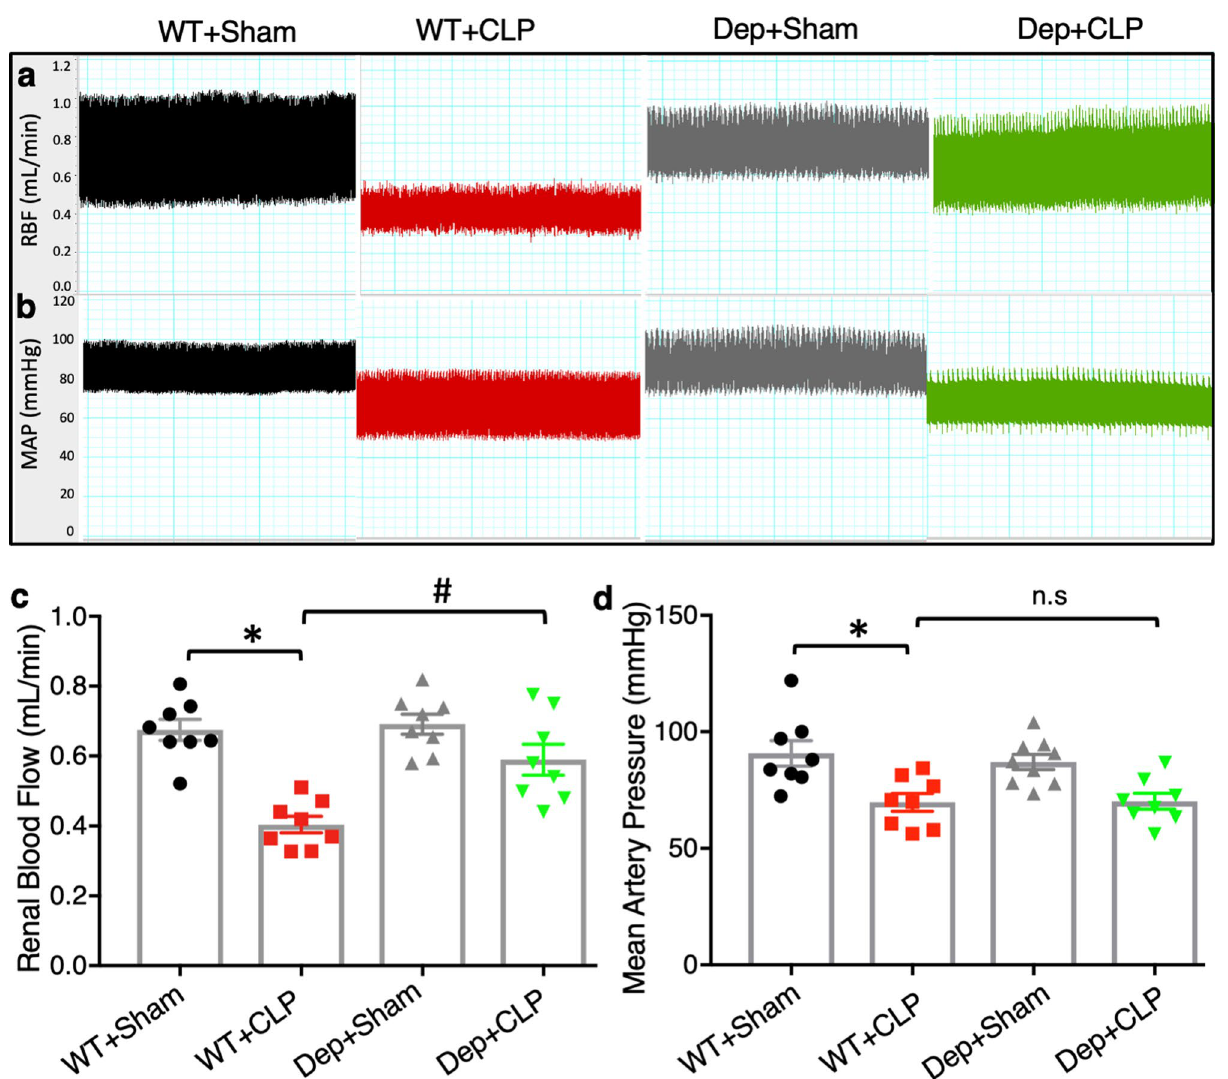
Figure 5. DHHC21 loss-of-function attenuates septic injury-induced reduction in renal blood flow. ( a , b ) Representative recordings of RBF ( a ) and MAP ( b ) in different groups 24 h after septic injury. Images are representative of 8 mice. ( c ) The reduced RBF in WT mice upon septic injury is rescued in Zdhhc21 dep/dep mice. n = 8 ( d ) No significant difference in MAP is observed between WT and Zdhhc21 dep/dep mice upon septic injury. n = 8. Results represent mean ± SEM. *p ≤ 0.05 versus WT + Sham, # p ≤ 0.05 versus WT +